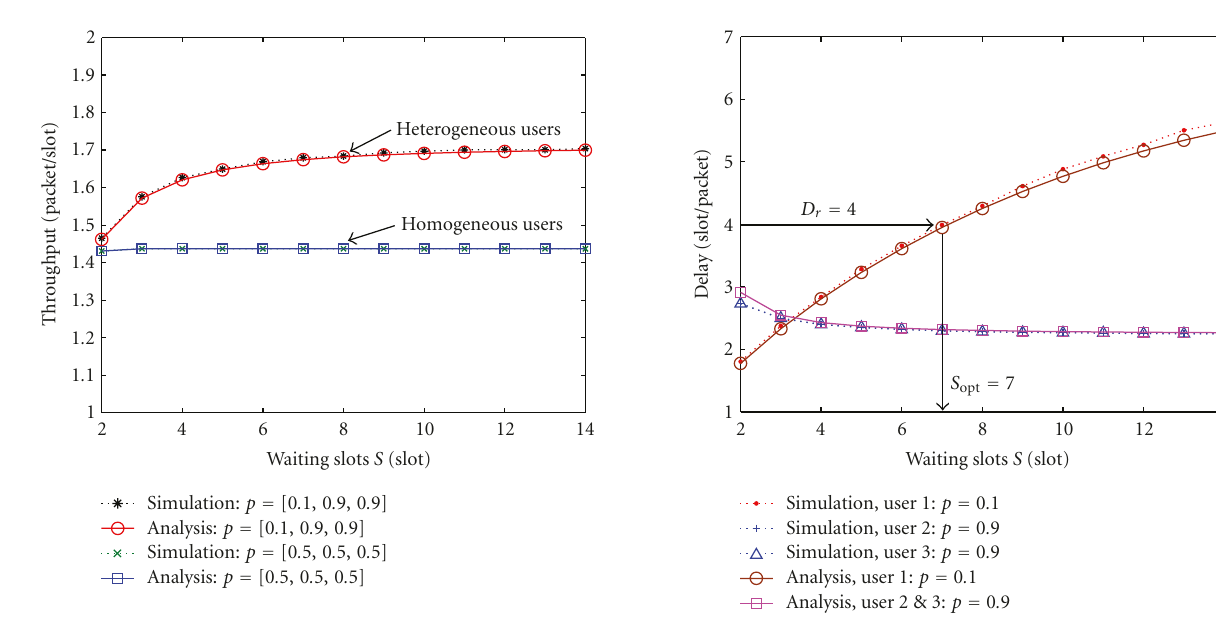
Figure 2: Mean throughput performance of the proposed MGPQ.